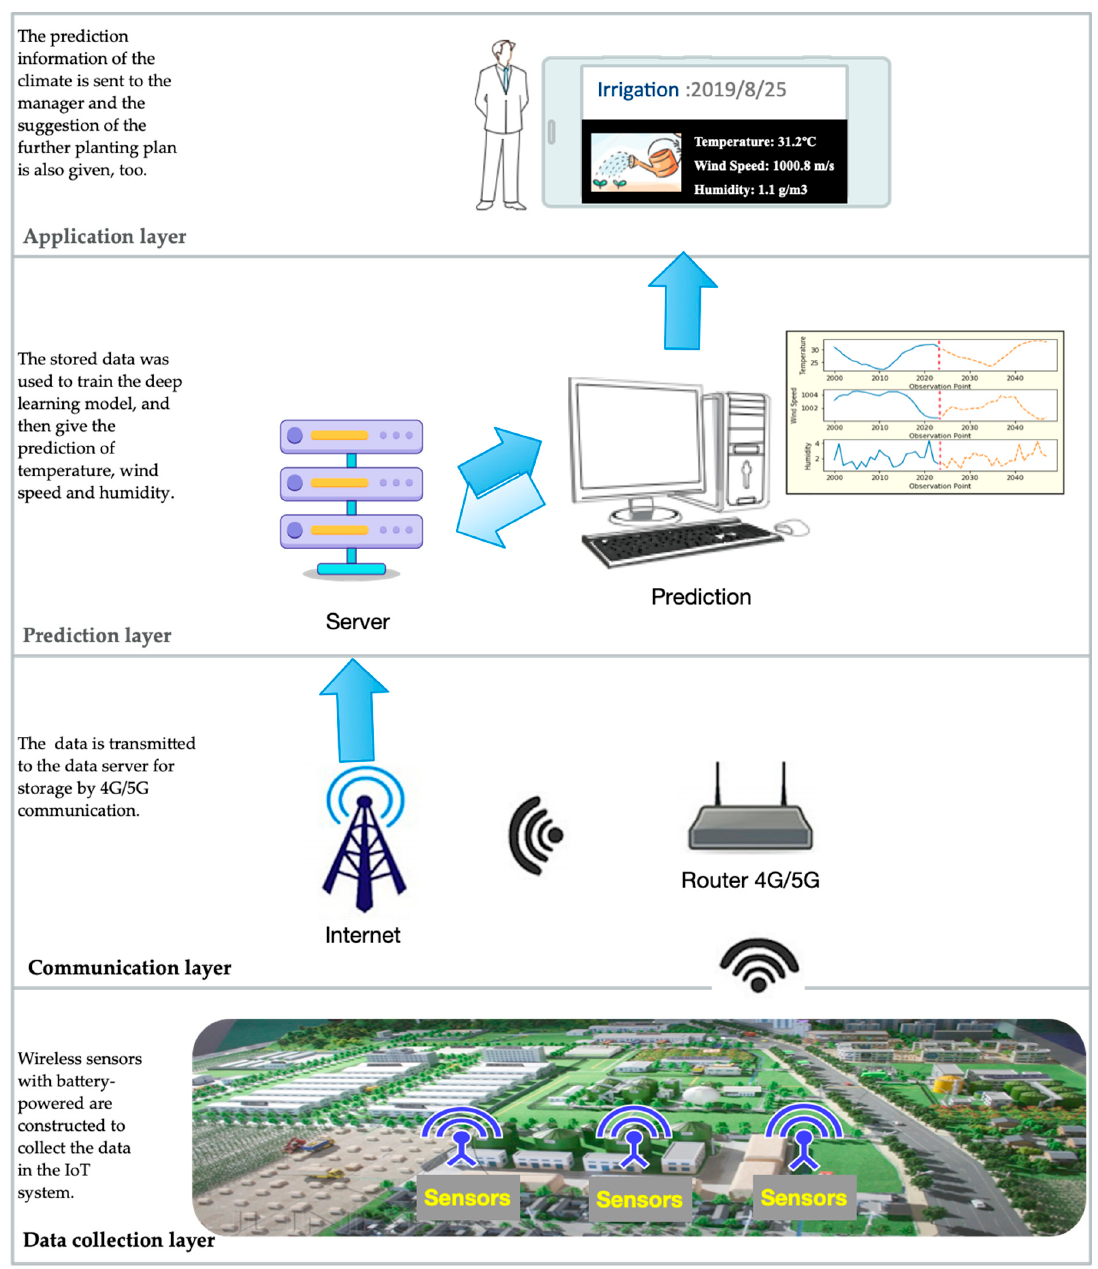
Figure 1. Data collection and prediction in an agricultural Internet of Things (IoT) system.